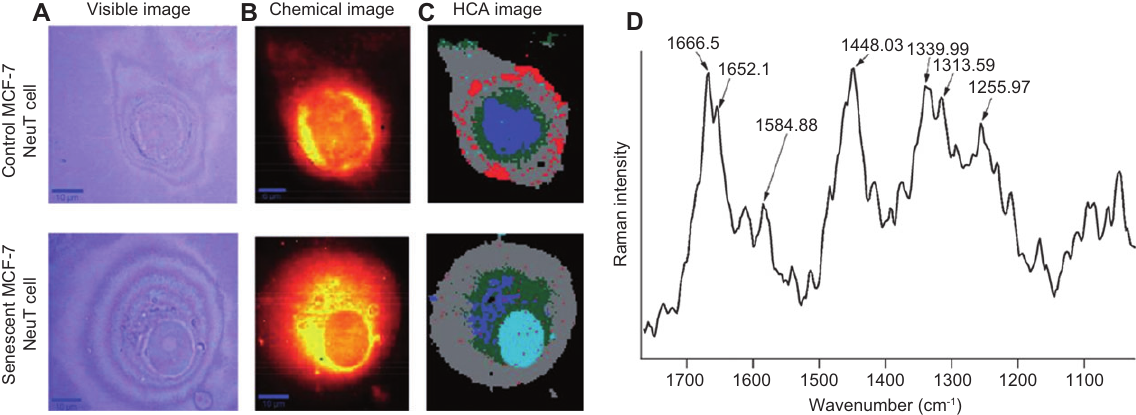
Figure 2 Raman imaging of single control and senescent MCF-7/NeuT cells. (A) Optical image of cells cultured onto quartz substrates and fixed with formaldehyde, using a 100 × objective lens. (B) Raman imaging based on CH stretching vibrations by the CytoSpec software. (C) Average nuclear spectra using unsupervised hierarchical cluster analysis. (D) Raman spectrum of the difference from average control and senescent MCF-7/NeuT cells. Reproduced with permission from: Mariani et al. (2010) . Copyright 2010, American Chemical